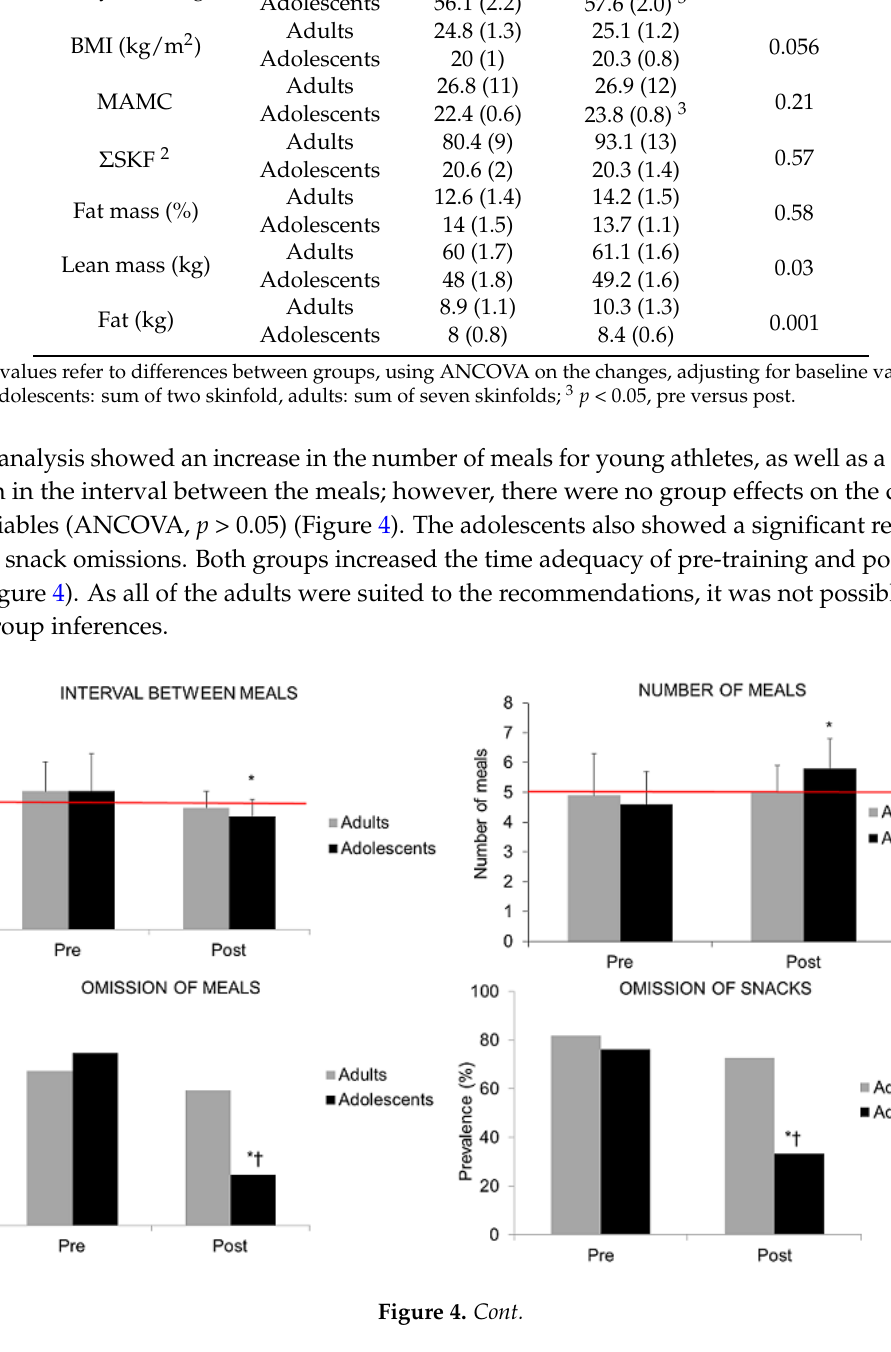
Figure 4. Number of meals, interval between meals, meal omission, snack omission, and time adequacy of pre and post ‐ training meals, before and after nutritional counselling. The red lines indicate the recommendations of at least five meals a day (number of meals) and a maximum of three hours between meals (interval between meals). * p < 0.05, pre versus post. † p < 0.05, adults versus adolescents. The within ‐ group analysis showed that there was a statistically significant increase in daily water intake among the adolescents (Table 2). There were no differences in the change scores between the groups (ANCOVA, p > 0.05). Table 2. Geometric mean (95% CI) of daily water intake and water ingestion during training.